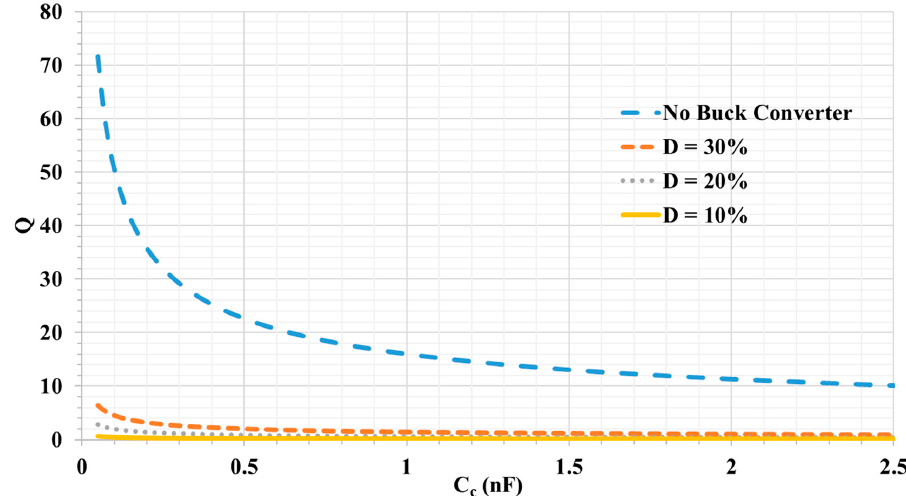
Figure 6. The change in the capacitive interface value effect on the Q value.